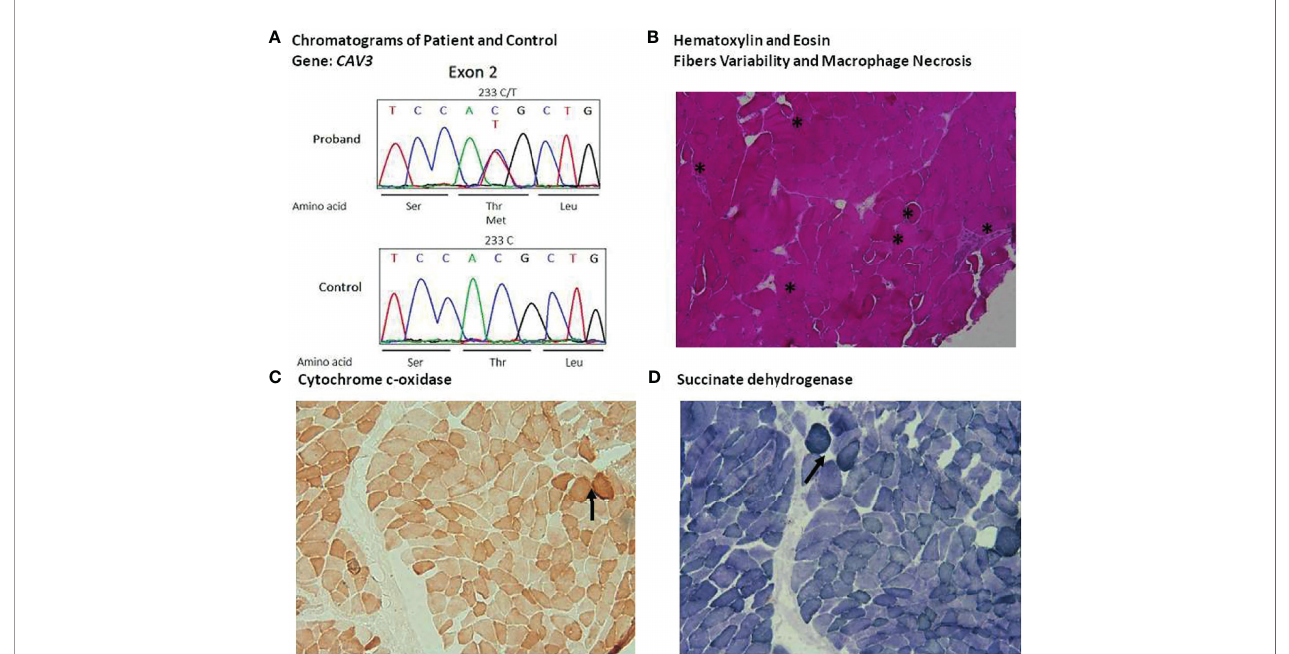
FIGURE 2 | I denti fi cation of the T78M variant of CAV3 and quadriceps muscle histological fi nding : (A) Sequence chromatogram of the normal and patient genome. (B) Haematoxylin and eosin (HE) staining (A) , 10X), highlighting considerable variability of fi bers size and morphology with several hypotrophic round fi bers, degenerating fi bers and macrophage necrosis (asterisks). Moreover, HE pointed out several slitting of fi bers. (C) Cytochrome c-oxidase panel (C) , 10X) and (D) succinate dehydrogenase stain panel (D) , 10X) showing some fi bers with modest alteration of oxidative metabolism